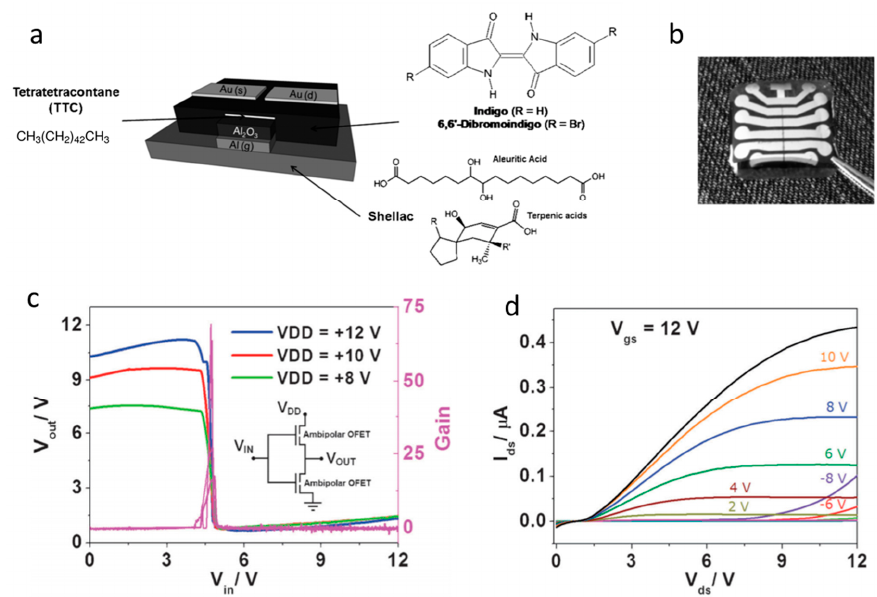
Figure 22. ( a ) The OFET device, using tetratretracontane (TTC) between the Al 2 O 3 dielectric and the indigo (or dibromoindigo) semiconductor. The substrate is a shellac (varnish) layer. ( b ) Pictures of a five-transistor sample on a shellac substrate. The W and L parameters are 1 and 80 mm, respectively. The capacitance of the TTC/Al 2 O 3 layer is was ca. 90 nF cm − 2 . ( c ) Quasi steady-state output characteristics of the indigo-based inverter. ( d ) Output characteristics. Adapted from [98]. Copyright © 2012 Wiley and Sons.